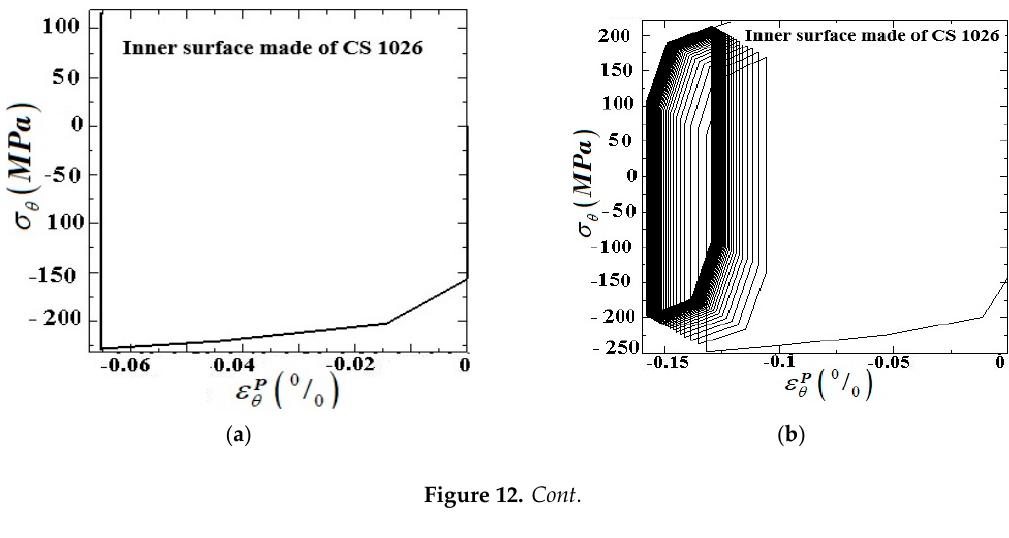
Figure 11. Corresponding stress–plastic strain curves in the circumferential direction of FGM tubes with outer surfaces made of CS 1026 under sustained internal pressure plus cyclic thermal loading for different types of elastic–plastic behaviors. ( a ) Elastic shakedown under P in = 0.43 P y and T in = 1.75 T y ; ( b ) plastic shakedown under P in = 0.65 P y and T in = 2.35 T y ; ( c ) ratcheting under P in = 0.75 P y and T in = 1.95 T y .